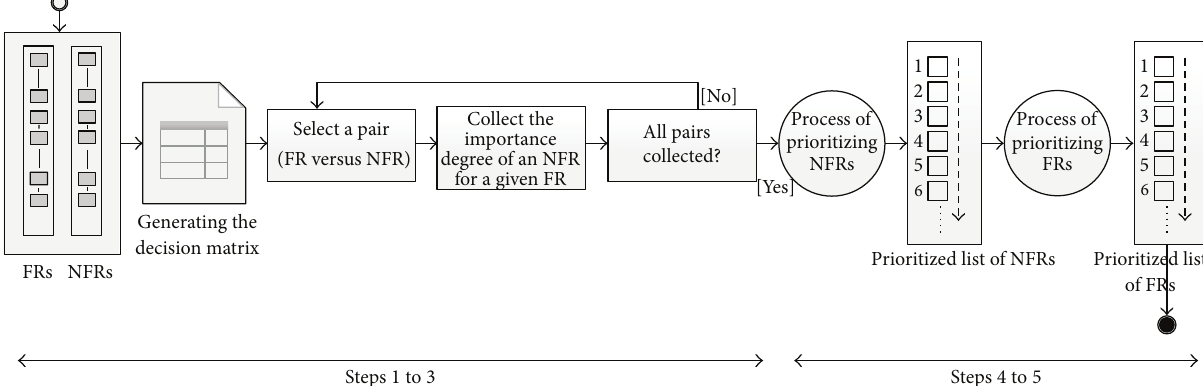
Figure 1: The integrated process of generating the prioritized lists of functional and nonfunctional requirements.